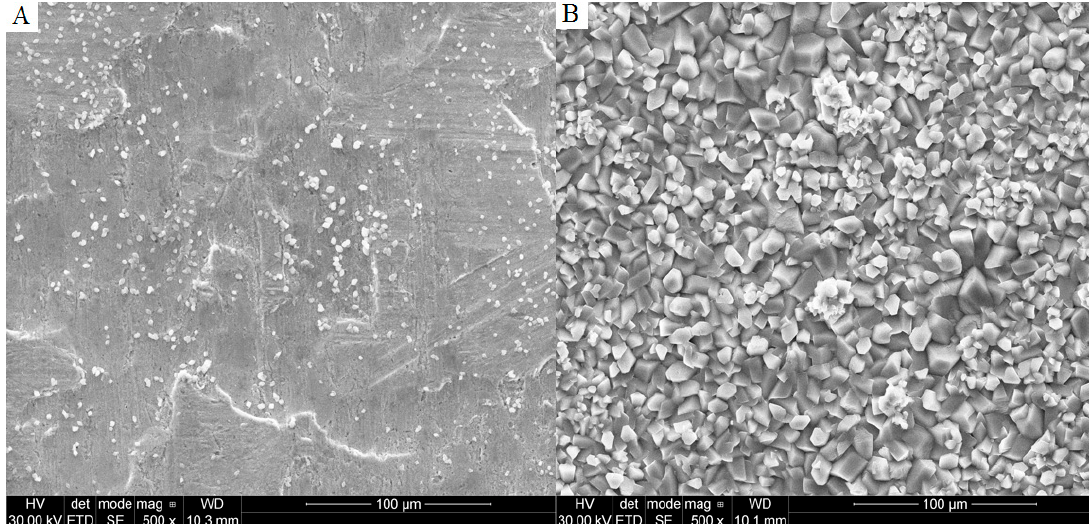
Figure 4. SEM images of as ‐ prepared samples: ( A ) After 15 s; and ( B ) after 900 s of the process. Materials 2018 , 11 , x FOR PEER REVIEW